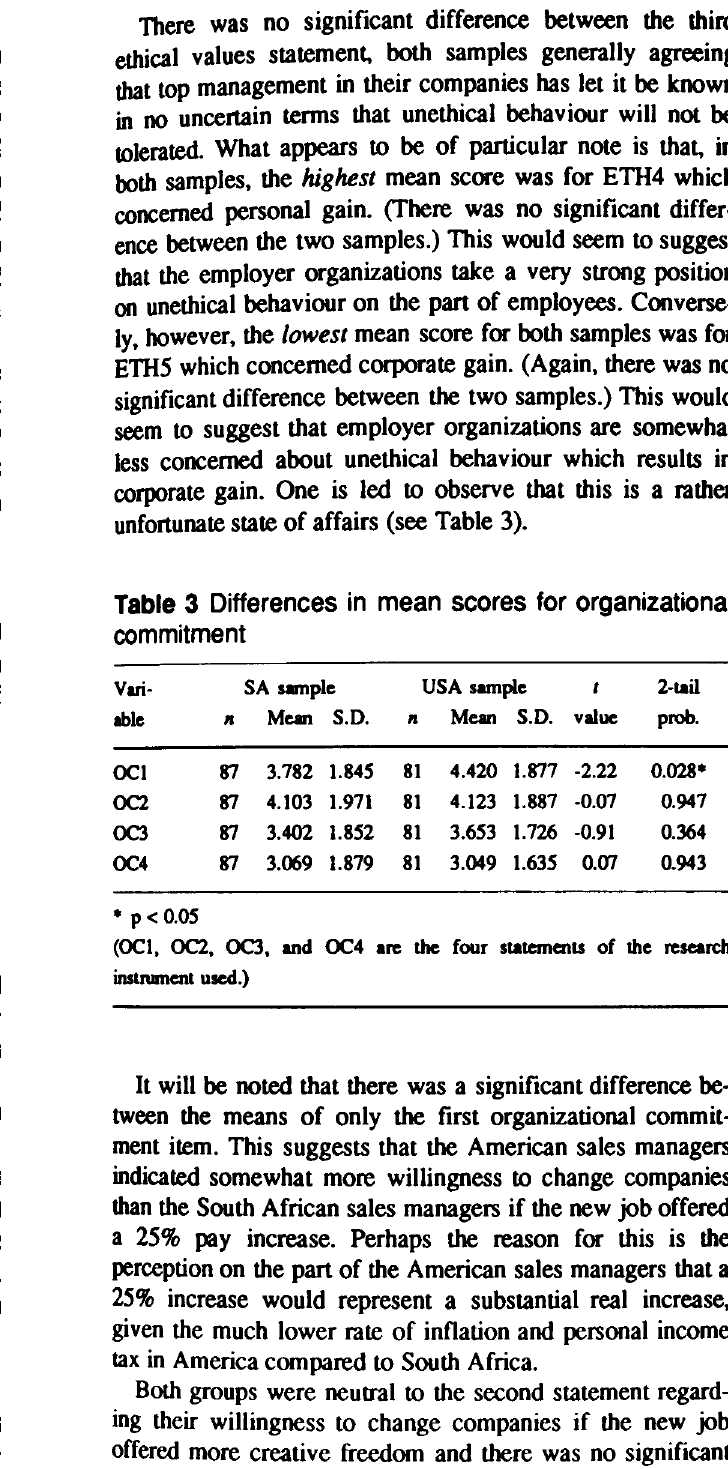
Table 5 Differences in mean scores for management decision